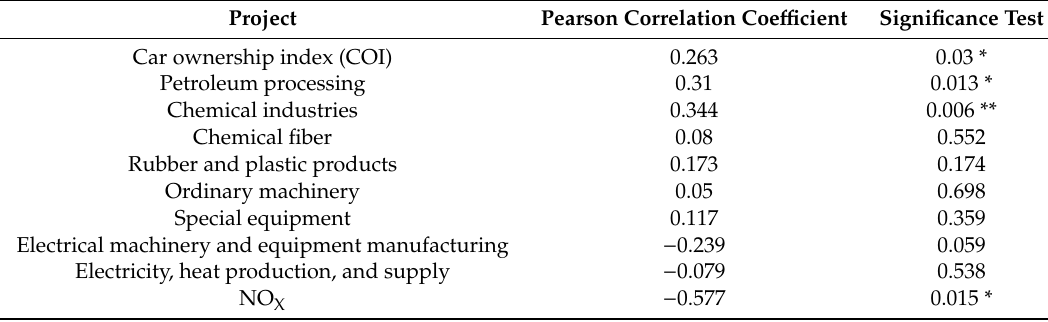
Table 2. Analysis of correlation between human factors and ozone